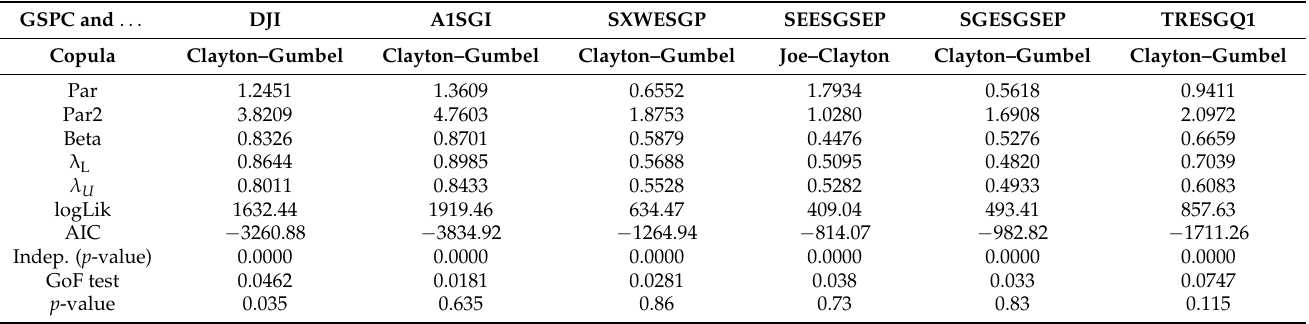
Table 5. Dependence structure for GSPC and ESG indices, 2 December 2009–30 July 2014.